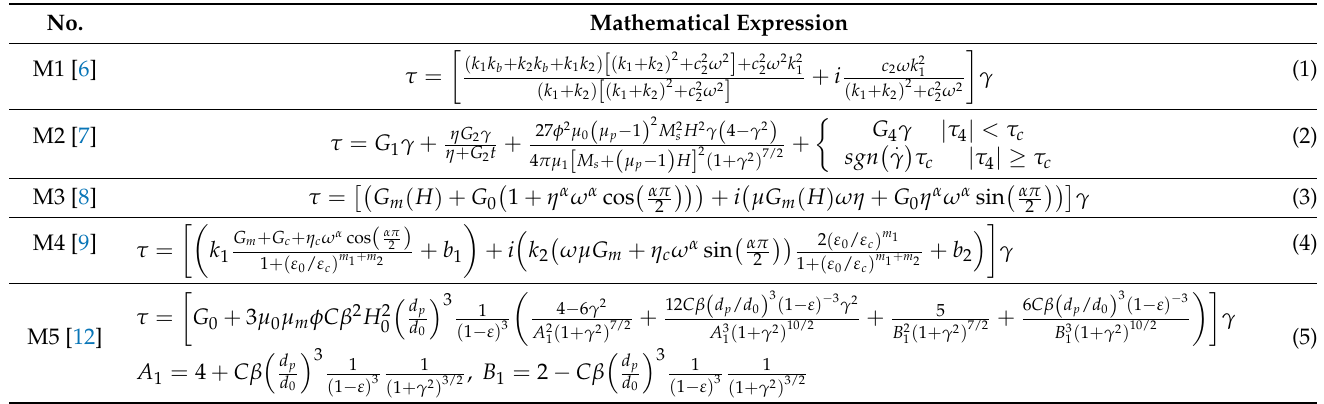
Table 1. Parametric Model of